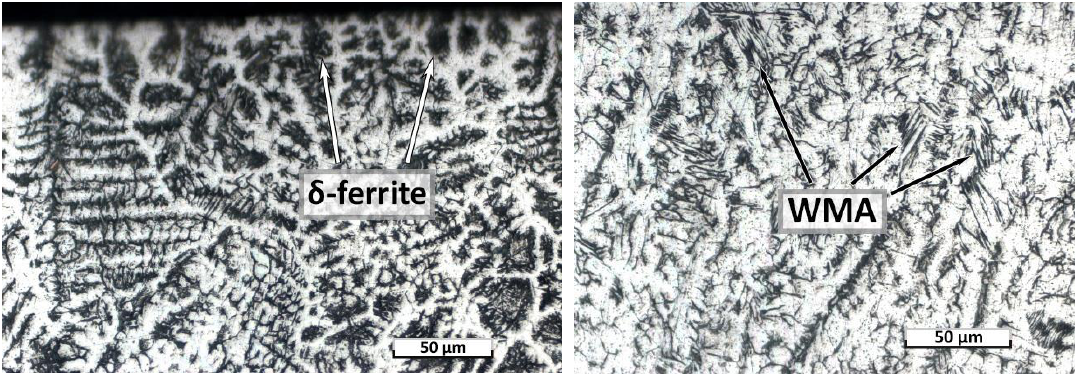
Figure 3. Microstructure of the top and bottom parts of the weld metal of a NHT sample.